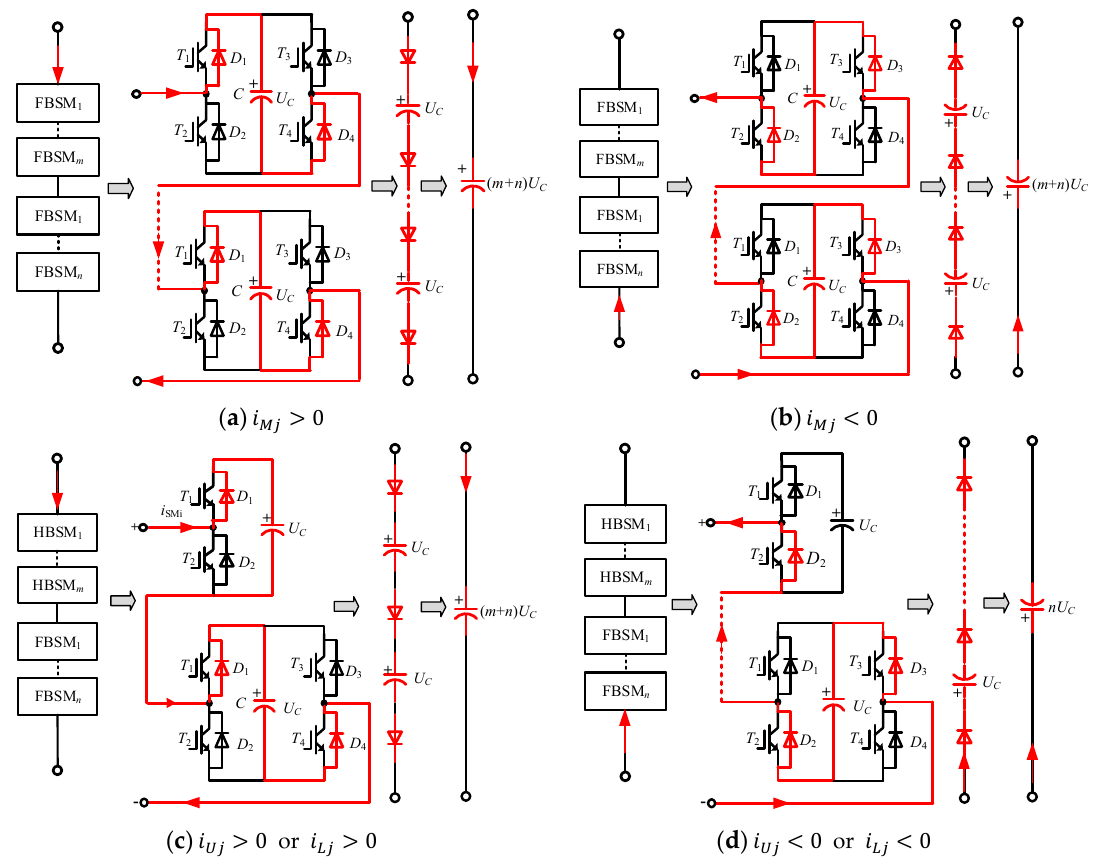
Figure 5. Equivalent circuits when all IGBTs in SMs are turned OFF.